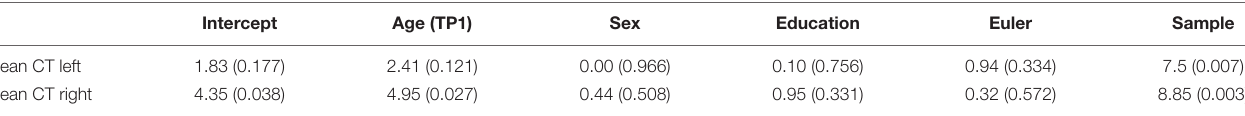
FIGURE 1 | Annual percentage changes (APC) in cortical thickness for (A) 1000BRAINS and (B) LHAB. Differences in SD between the two samples is shown in (C) together with a corresponding density plot (D) showing the variance in cortical thickness for 1000BRAINS and LHAB within the postcentral gyrus. TABLE 4 | F and p -values derived from general linear models assessing annual percentage changes in cortical thickness in relation to sample, age, sex, education, and data quality (Euler